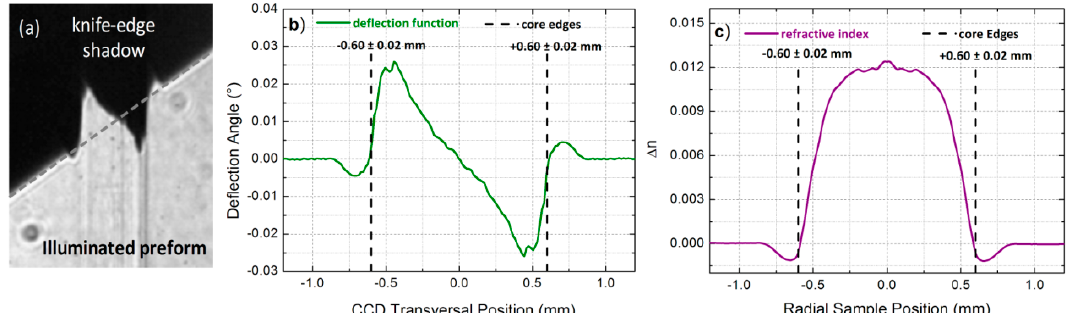
Figure 4. ( a ) Charge-coupled-device (CCD) image of the sample as-illuminated with a half-part obscured by a knife-edge filter, ( b ) deflection angle function extrapolated by the black-and-white profile in the CCD acquisition, and ( c ) refractive-index profile calculated using an integration of the deflection function.